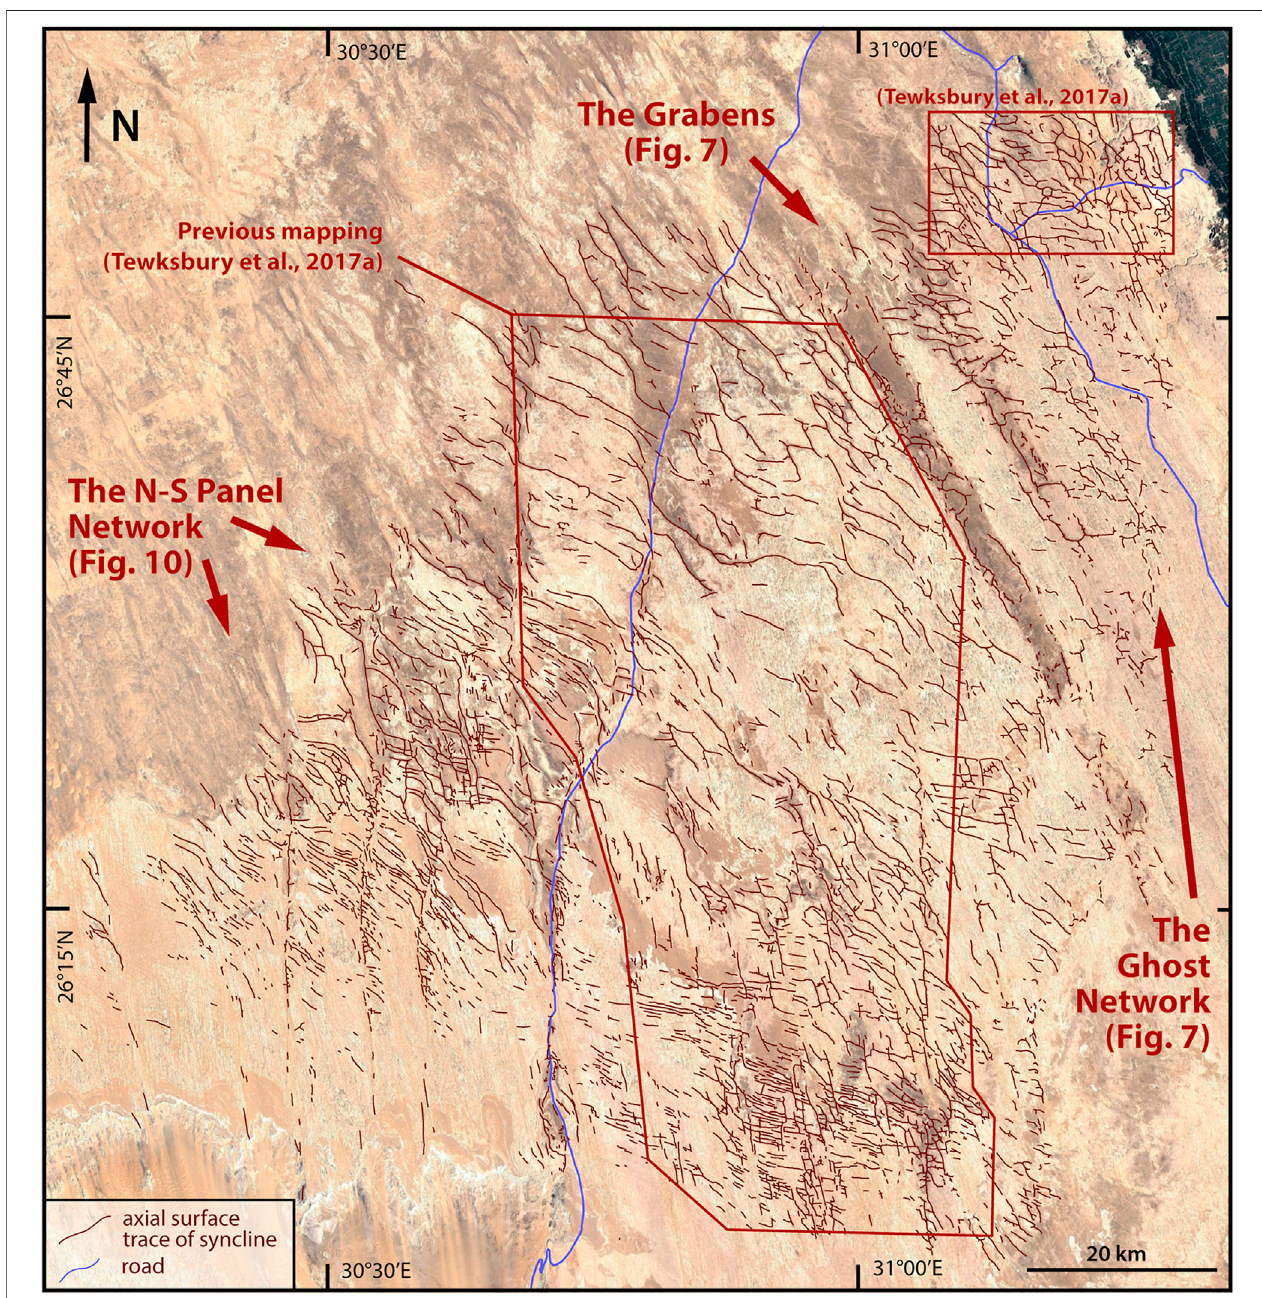
FIGURE6| Synclinenetwork,showingaxialsurfacetracesofallsynclinesmappedtodate.Includesnewmappinginthreeareasaddressedseparatelyinthispaper (theghostnetwork,theN – Spanelnetwork,andthegrabensarea),plusanupdateofthenetworkmapfromTewksburyetal.(2017a)(redoutlines).AreasinNW,SE,and Sthat showno synclines havenot yetbeen mapped;they arenot syncline-free.Satellite imagerysource: Google Earth. See theDataAvailability Statement for accessto the full mapping data set as a kmz fi le.